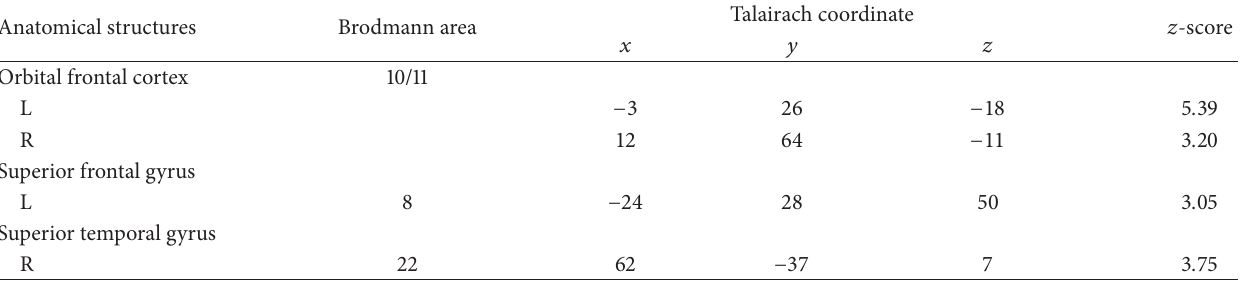
Table 5: Regions showing significant changes in rCBF by the subtraction of chord minus complex condition. Anatomical